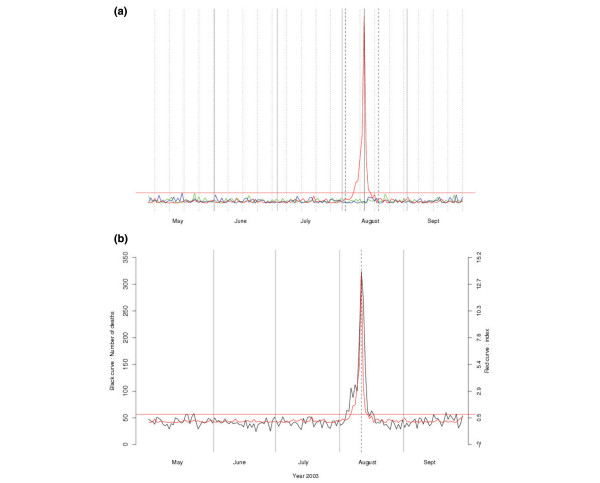
The Paris Index of Heatstroke Related Excess Mortality. The three annual periods were superimposed and synchronised weekly. The vertical dashed lines define the heat-wave period (3–19 August 2003). The alert threshold was defined as the maximum value of the Paris Index of Heatstroke Related Excess Mortality (PIHREM) outside the heat-wave period (horizontal red line). (a) Indicator calculated using the whole data (2001, blue curve; 2002, green curve; 2003, red curve) (b) The PIHREM (red curve) and Paris mortality (black curve).